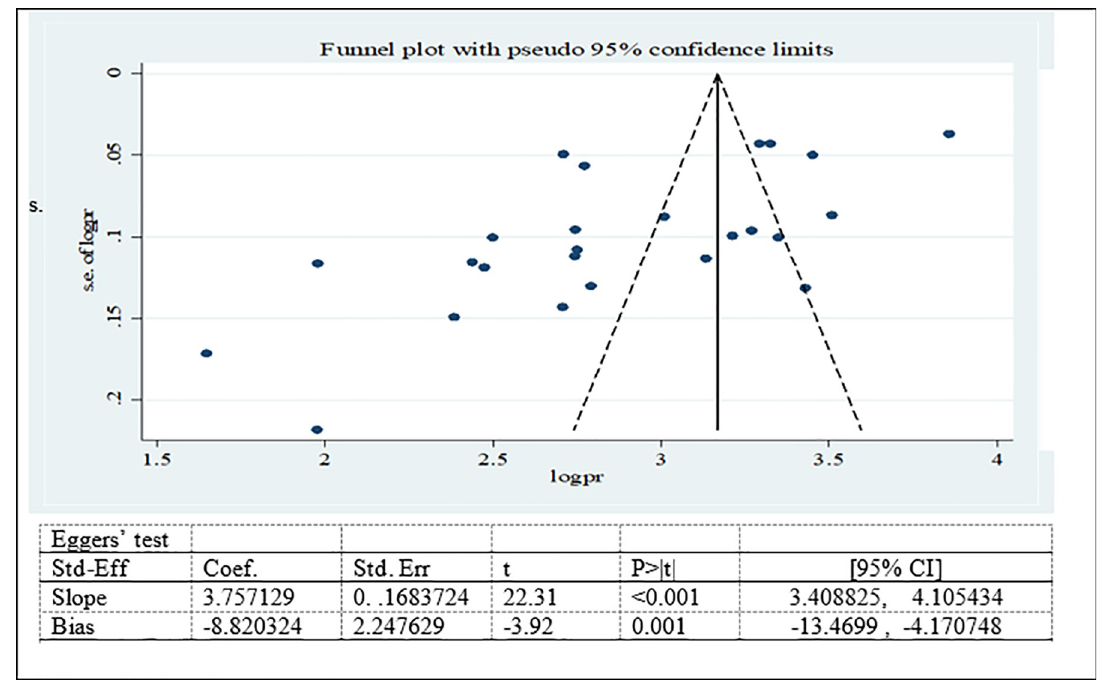
Fig 8. Funnel plot and Eggers’ test to assess publication bias for adolescent stunting in Ethiopia.